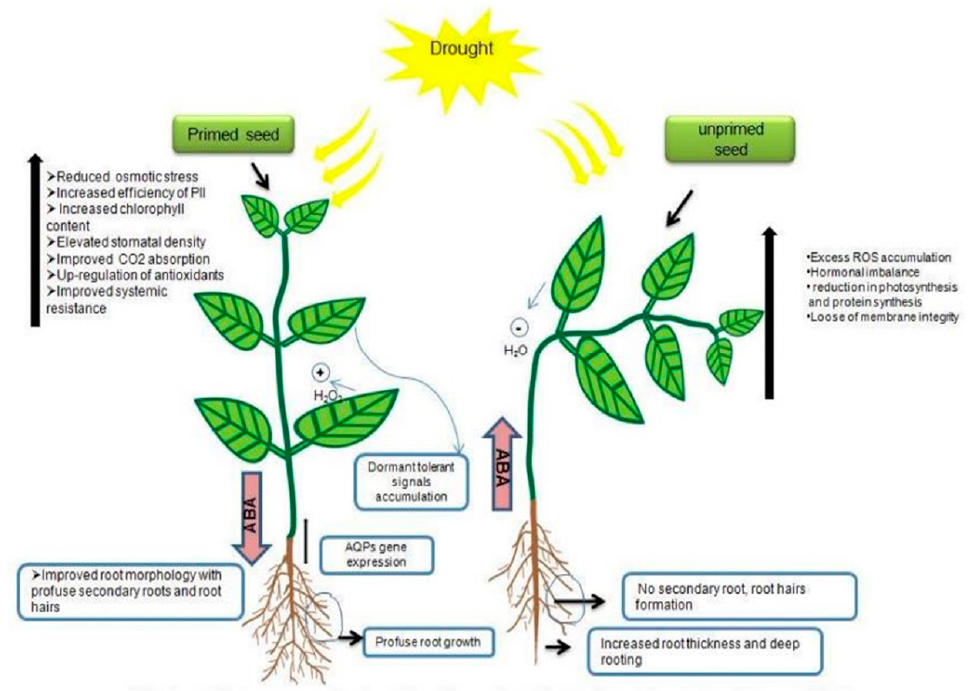
Figure 4. Performance of primed and unprimed seeds under drought condition.